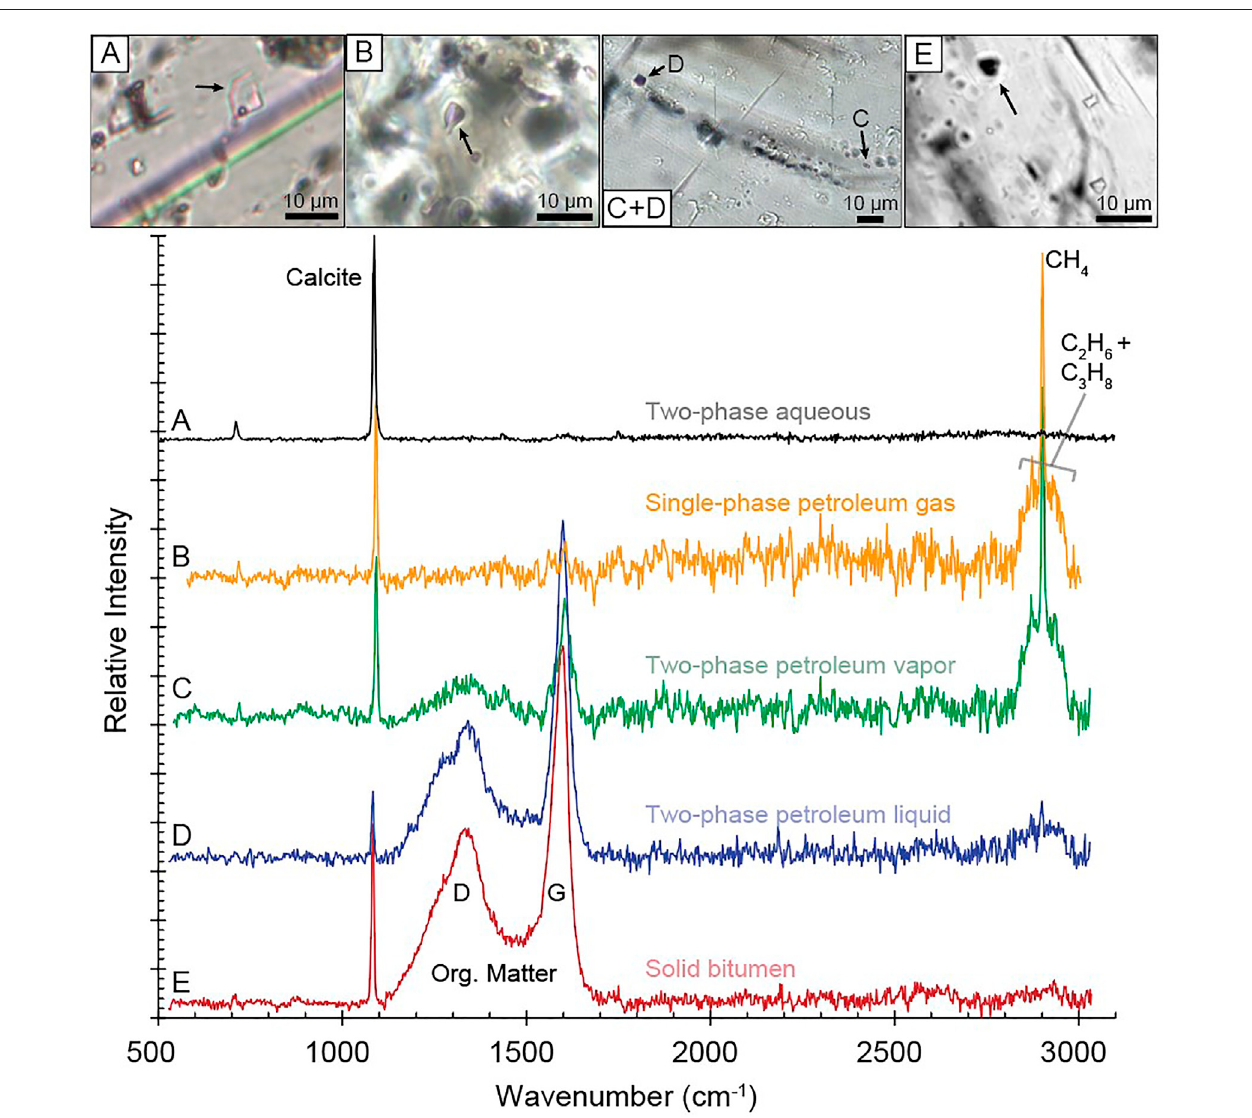
FIGURE 7 | Raman spectra of fl uid inclusions, note that fl uorescence background has been subtracted from all spectra. (A) . Two-phase aqueous fl uid inclusions showing strong calcite peaks associated with host material and an absence of hydrocarbons. (B) . Single-phase petroleum gas fl uid inclusion showing strong methane band and associatedhydrocarbongases(e.g.,ethane, propane, etc.). (C) .Two-phase petroleum vapour fromvapourbubble showing large methaneband and organic matter D- and G-bands. (D) . Two-phase petroleum liquid fl uid inclusions with strong D- and G-bands and weak methane band. (E) . Solid bitumen inclusions showing typical D- and G-band organic matter